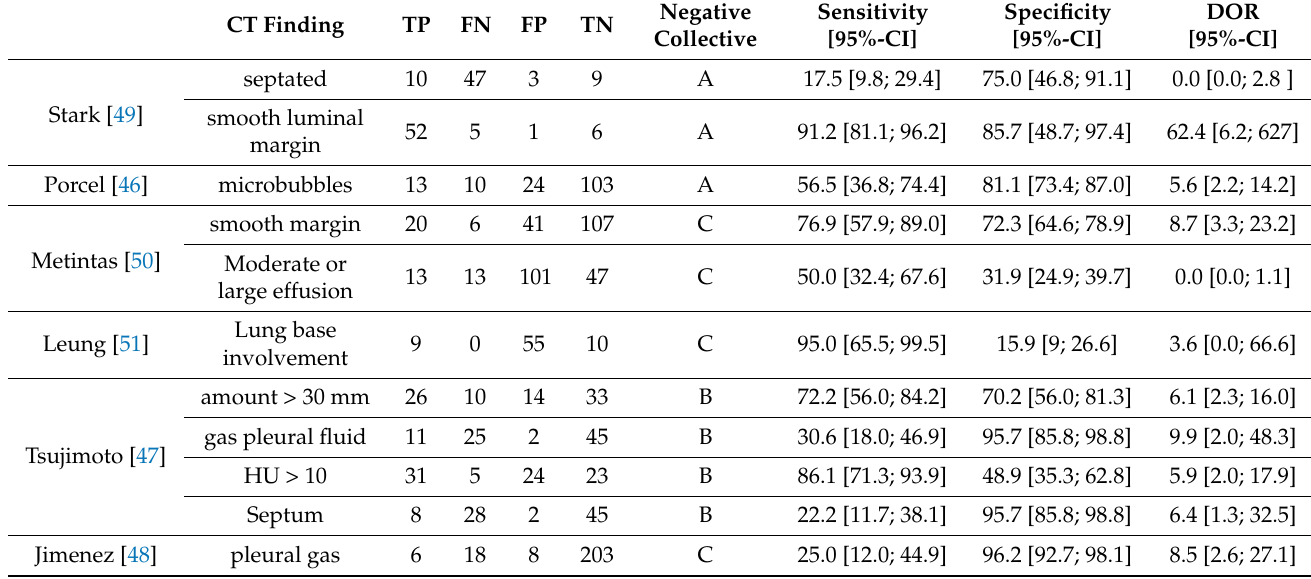
Table A2. Narrative summary of CT findings.